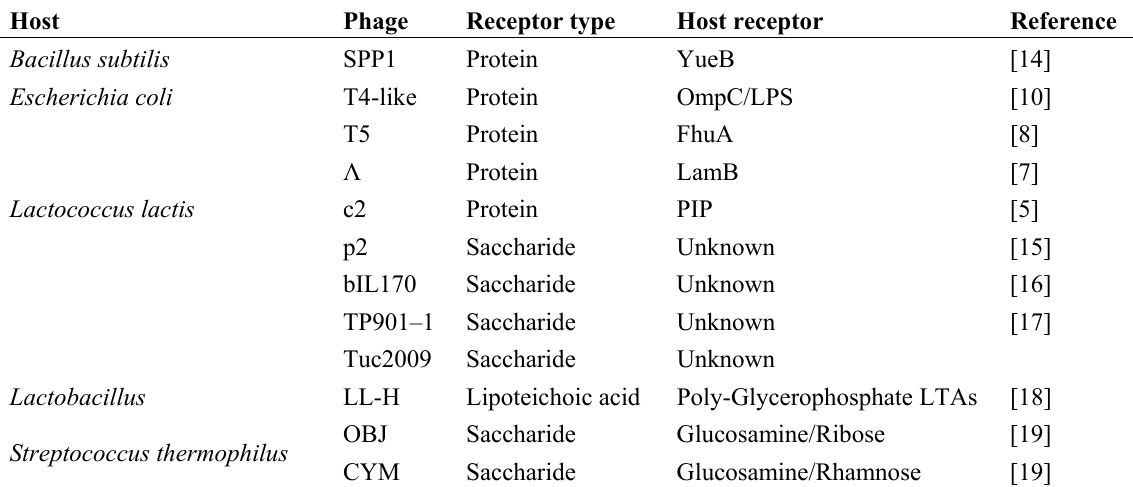
Table 1. Proven and putative phage